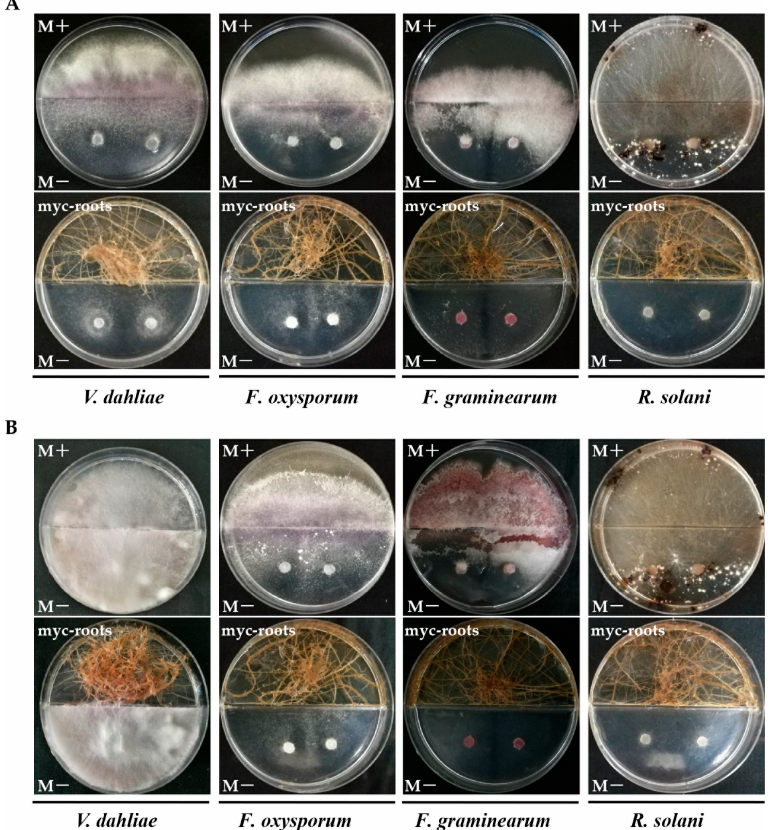
Figure 8. Antifungal activities of AMF symbionts against several soil-borne fungi at 7 dpi ( A ) and 50 dpi ( B ), respectively. The culture conditions were as described for Figure 7. The upper compartment contained M+ medium with or without AMF symbionts (myc-roots), and the downward compartment contained M − medium inoculated with two discs of Verticillium dahliae , Fusarium oxysporum , Fusarium graminearum and Rhizoctonia solani . Experiments were repeated three times with similar results.